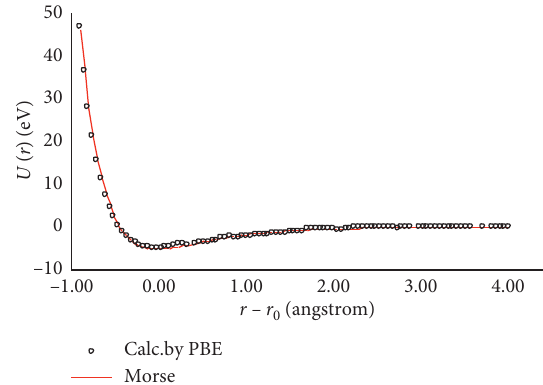
Figure 1: Potential energy vs. diatomic distance for UC.